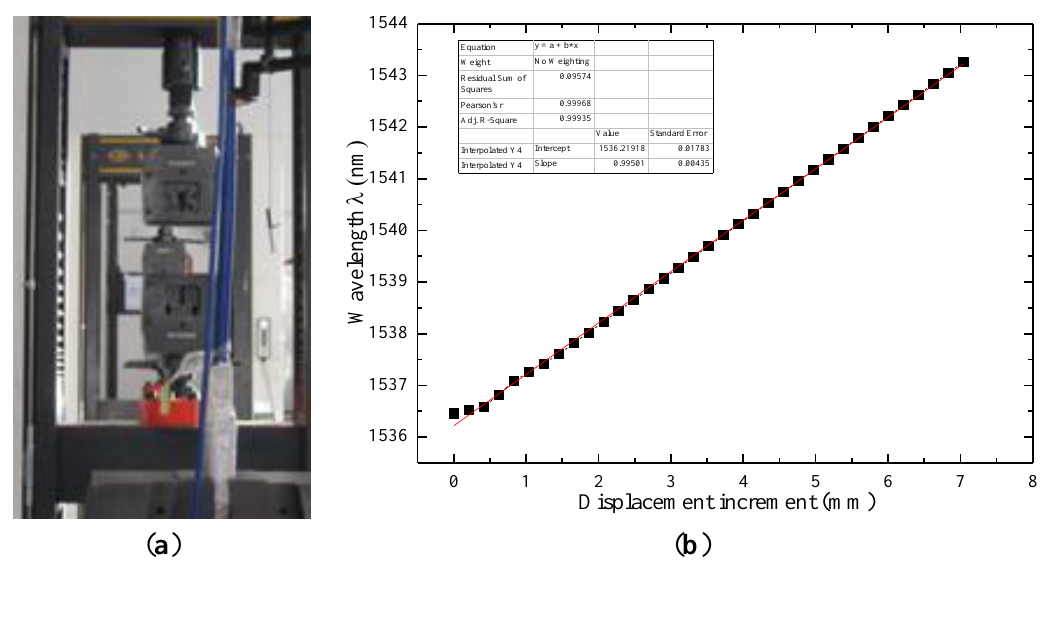
Figure 12. Tension test and strain data of the armoring-wire encapsulated FBG sensor. ( a ) Tension test; ( b ) The fitted